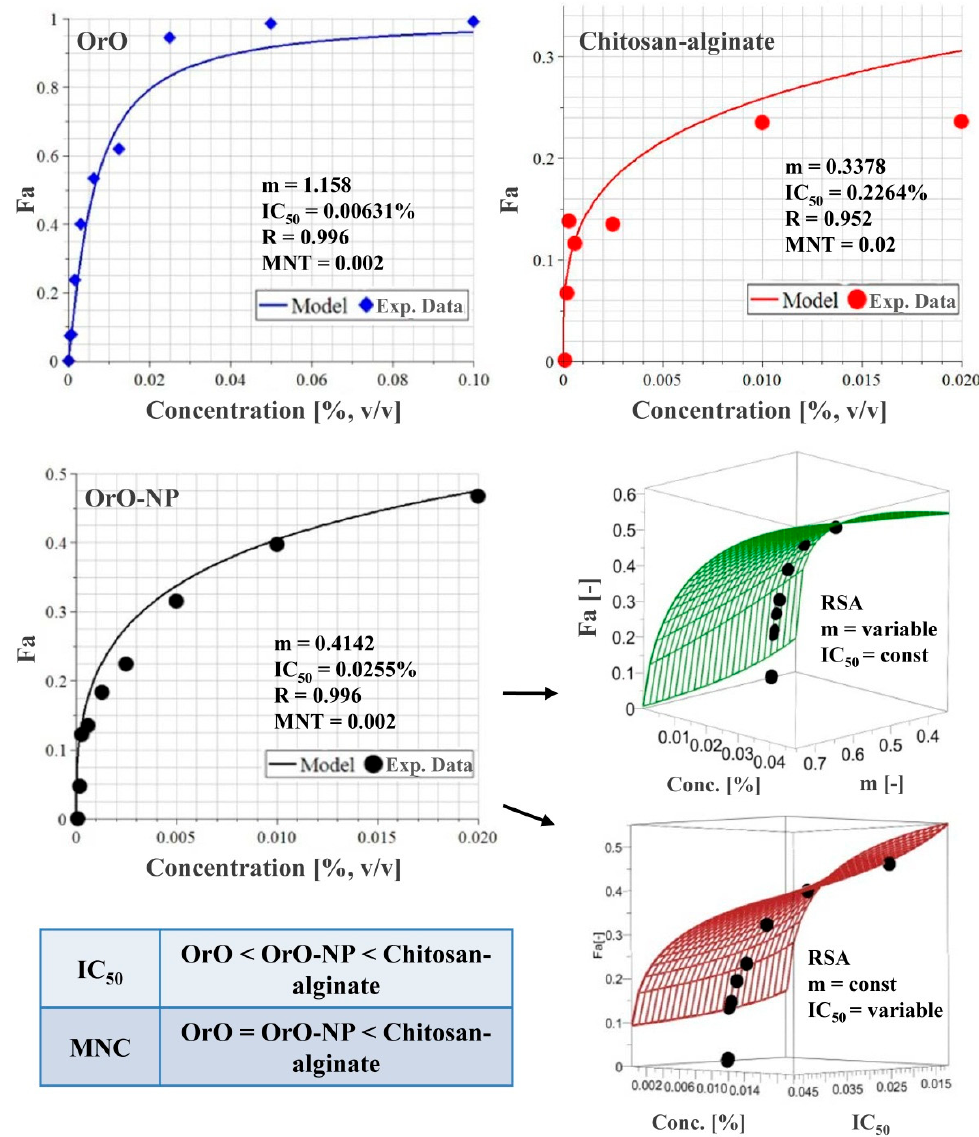
Figure 6 . Median inhibitory concentrations, maximum nontoxic concentrations and RSA analysis